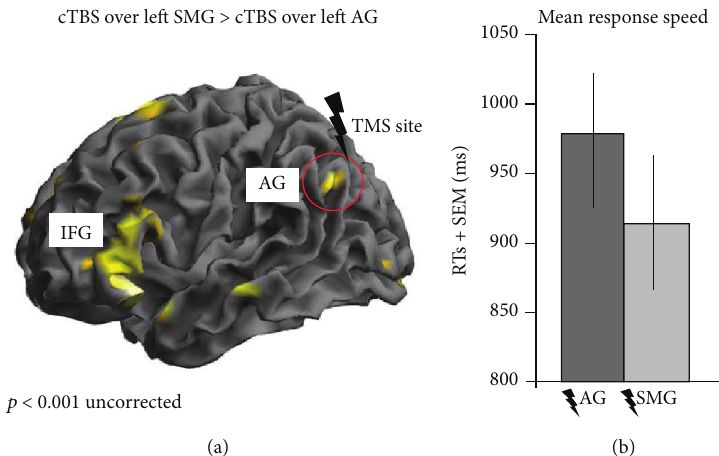
Figure 2: TMS-induced suppression of the semantic network during a word decision task in a representative subject. (a) Illustration of the strong remote effects induced by continuous theta burst stimulation (cTBS) given over the left angular gyrus (AG) prior to fMRI. Relative to cTBS over the neighboring supramarginal gyrus (SMG), cTBS of AG inhibited task-related neural activity during semantic decisions in the stimulated area as well as in the left inferior frontal gyrus (IFG) and in temporal regions. (b) Effects of cTBS on the mean reaction times (RTs) of semantic decisions. SEM = standard error of the